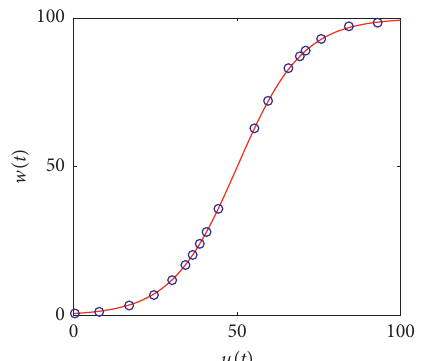
Figure 15: Comparison between real nonlinear function tansig (red) and captured nonlinearity (blue circles). Results obtained on numerical example 2.